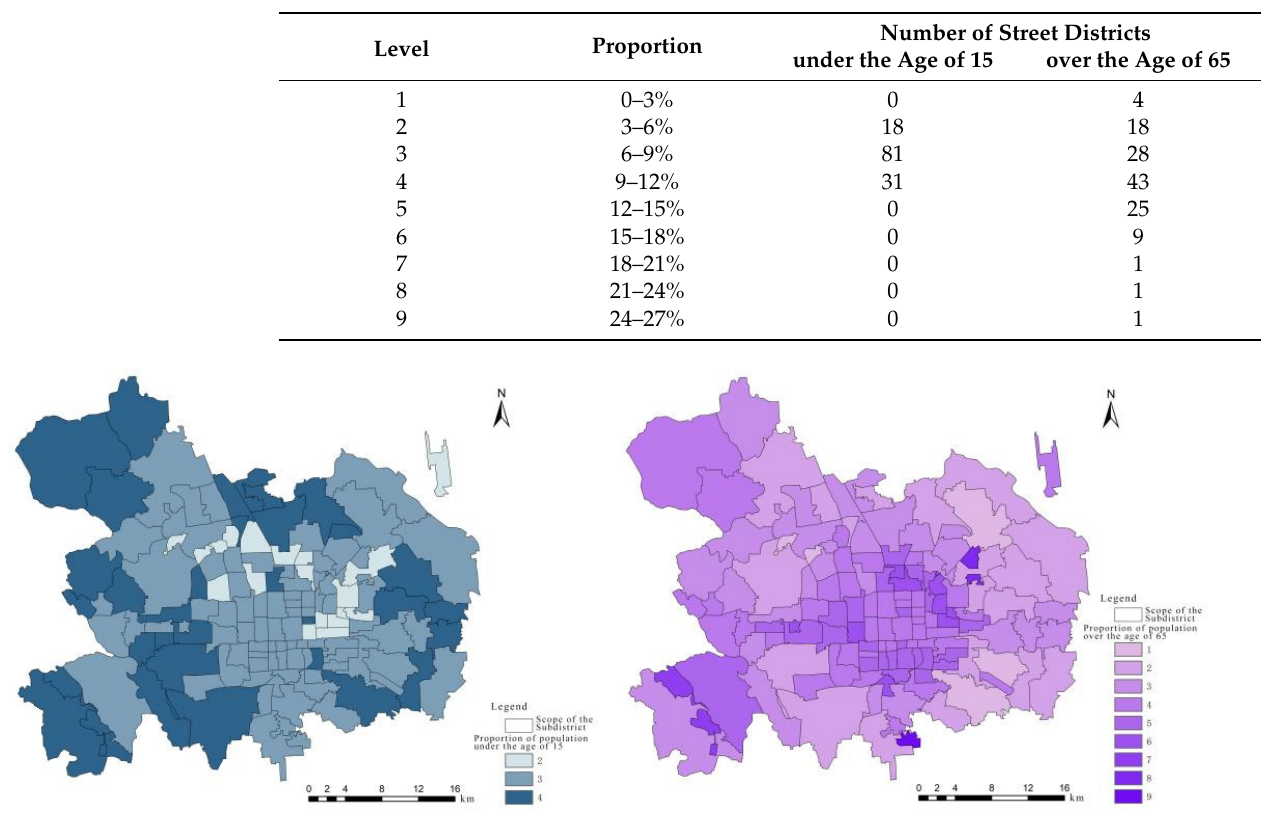
Figure 4. Population distribution in street districts in the central urban area of Beijing ( left : population proportion under the age of 15 years; right : population proportion over the age of 65 years).